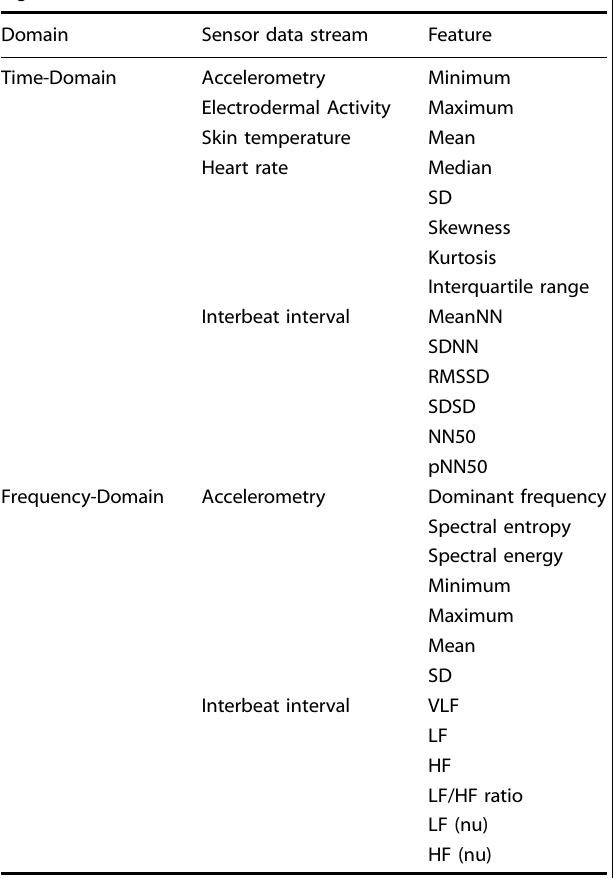
Table 3. List of features extracted from E4 physiological sensor